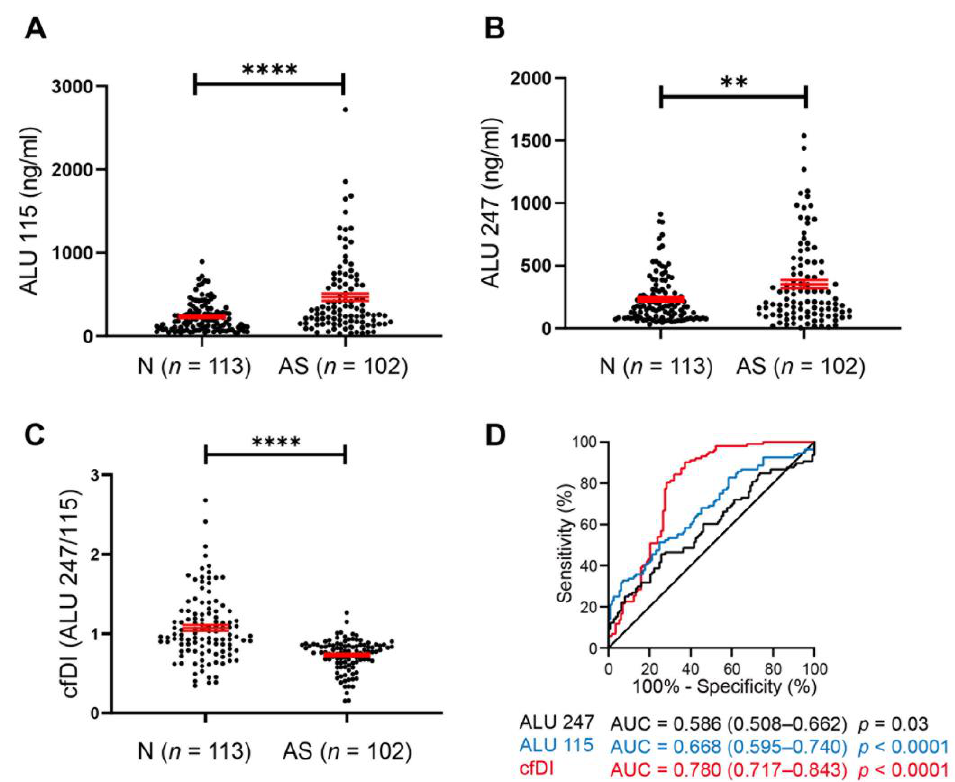
Figure 1. cfDNA acts as a new biomarker in atherosclerosis (AS). ( A , B ) The cfDNA concentration of short fragments (ALU 115) ( A ) and long fragments (ALU 247) (B) in AS patients and normal individuals. ( C ) The level of cfDI (cfDNA integrity, ALU 247/ALU 115) in patient group and control group. ( D ) ROC curves of ALU 115, ALU 247 and cfDI. Data are shown as mean ± SEM and were evaluated by unpaired t test. ** p < 0.01, **** p < 0.0001.